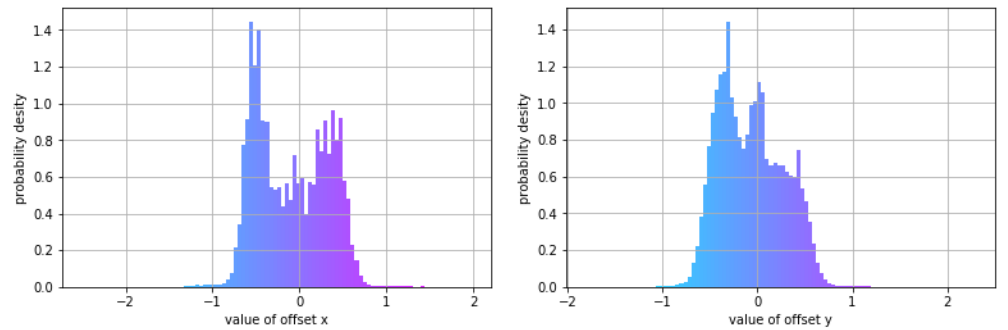
Figure 8. Offset histograms of data used: ( left ) x offset of the entire data set; ( right ) y offset of the entire data